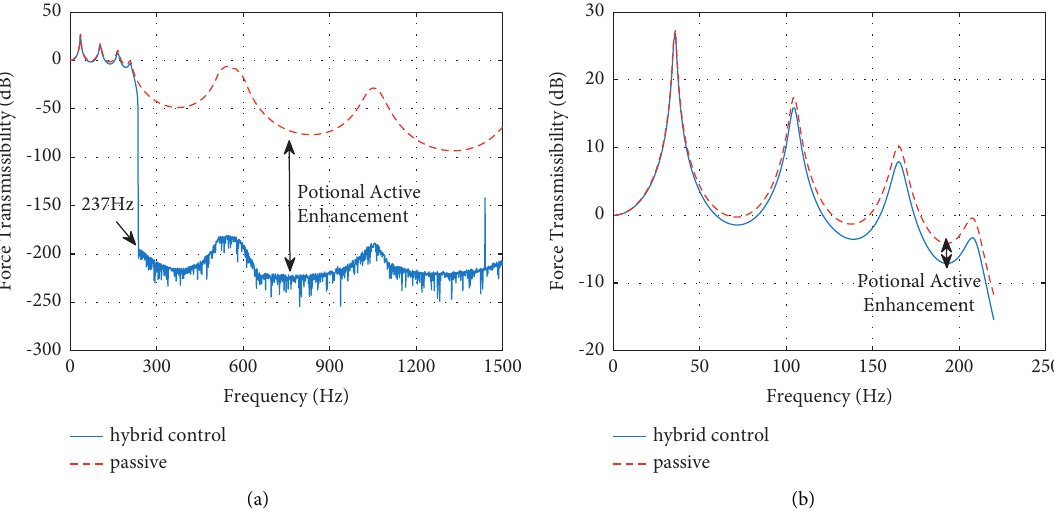
Figure 11: Minimum force transmissibility of PSPS by optimizing the voltages and currents. (a) Minimum force transmissibility of PSPS within 1500Hz. (b) Minimum force transmissibility of PSPS within